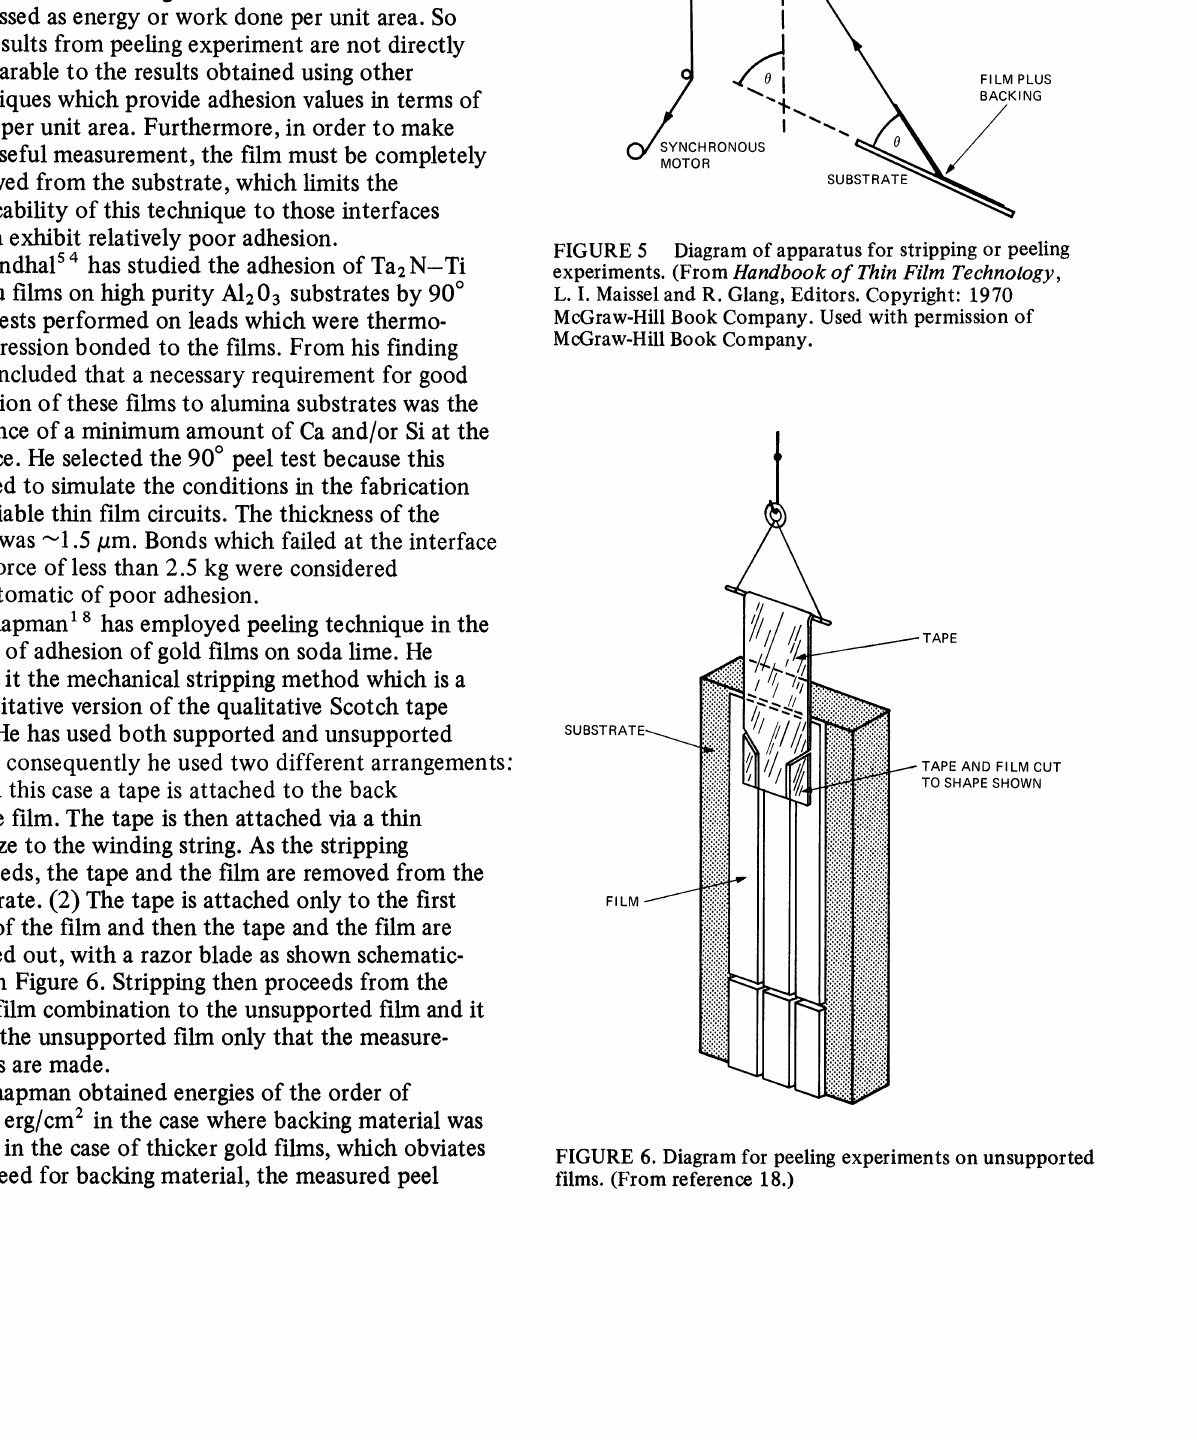
FIGURE 6. Diagram for peeling experiments on unsupported films. (From reference